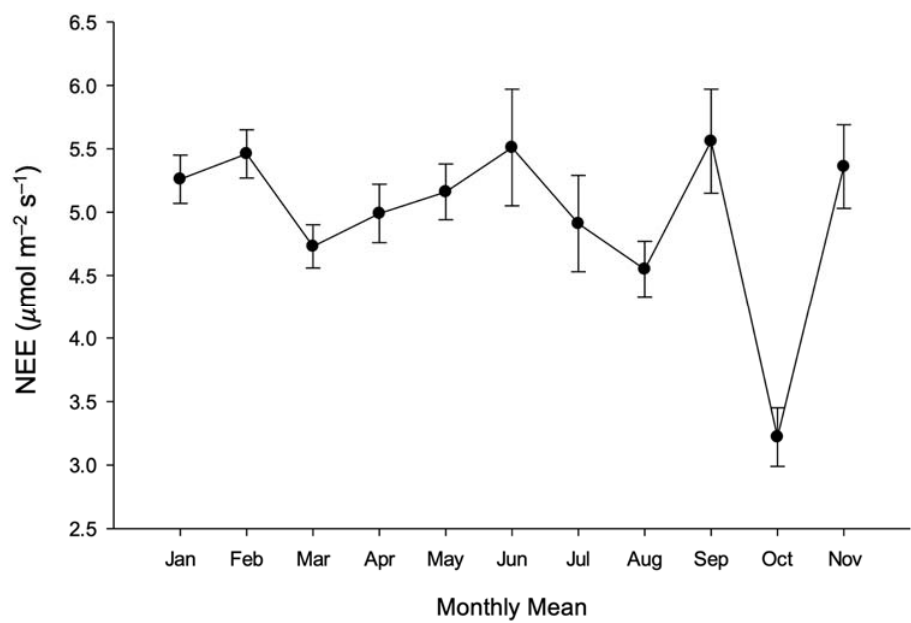
Figure 6. Monthly net ecosystem exchange (NEE) or CO 2 emission rates measured using the eddy covariance (EC) technique.